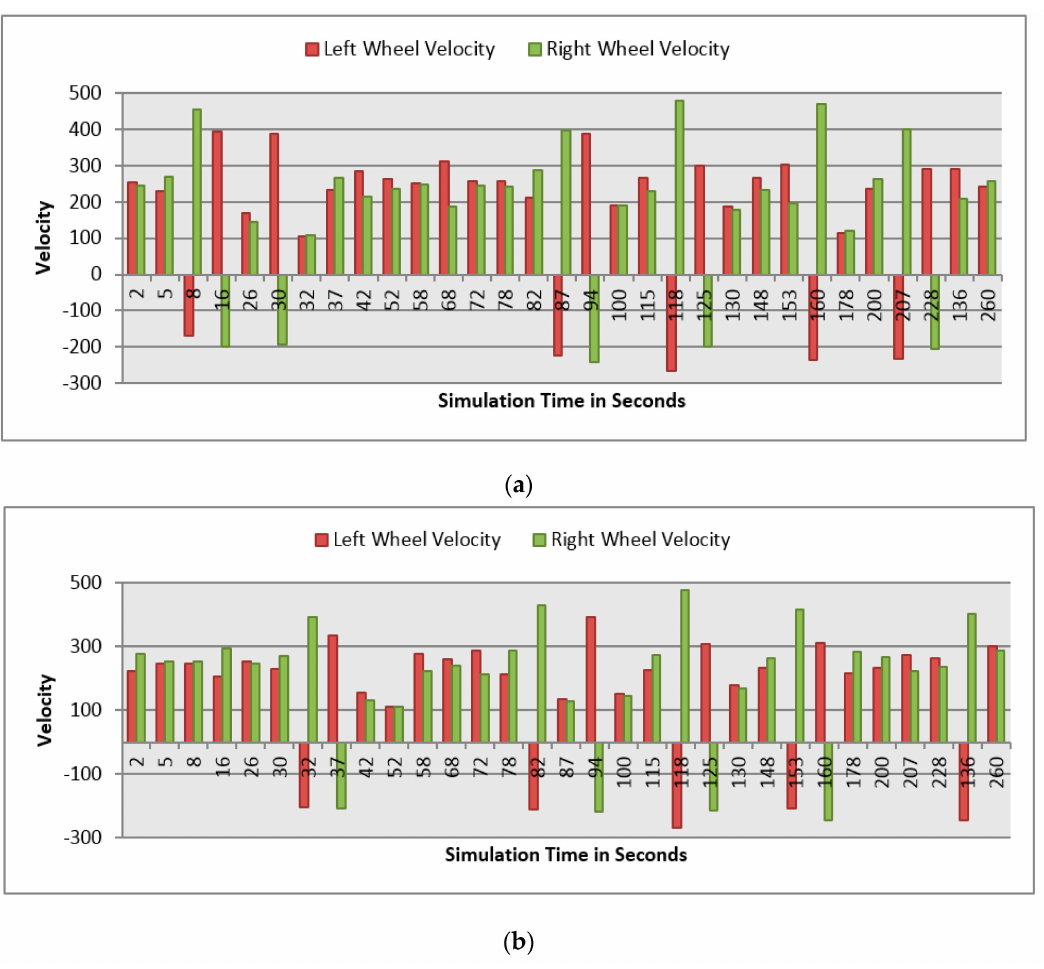
Figure 14. Left and right velocities for both robots at different simulation times. ( a ) Left and right velocities for Robot 1; ( b ) Left and right velocities for Robot